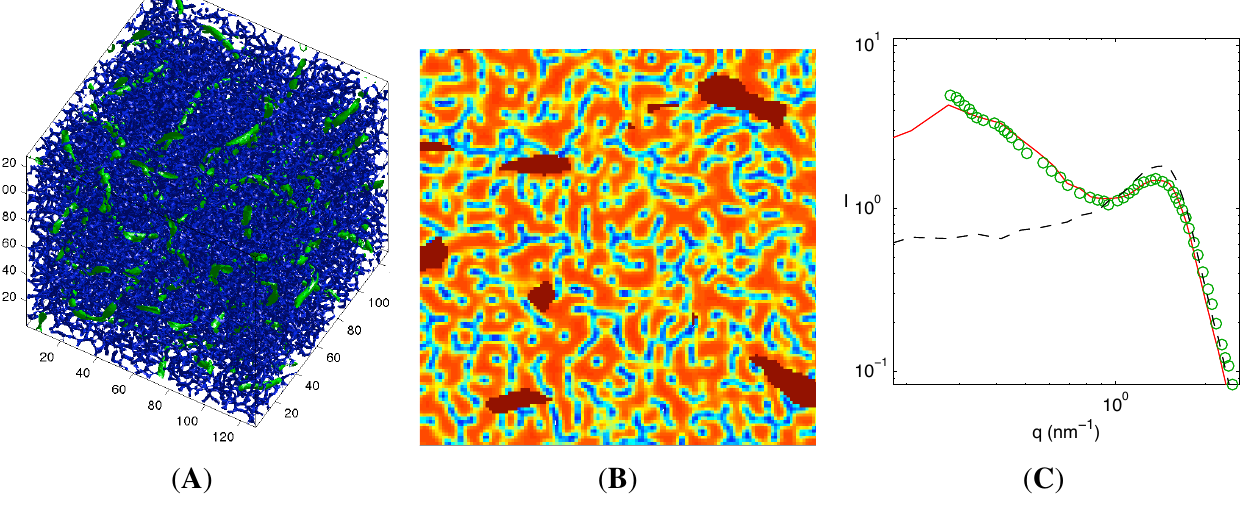
Figure 8. ( A ) Superposition of a 20% volume fraction solvent network (blue), calculated from the binary FCH energy with (cid:15) = η = 0 . 03 , η = 0 . 15 , and well tilt τ = 0 . 4 , with h m − 10% volume fraction crystalline network (green), calculated from the binary FCH energy with (cid:15) = η = 0 . 1 η = 0 . 2 and τ = 0 . 1 ; ( B ) Cross-section of solvent-crystalline h m − superposition, solvent (blue), polymer (orange), crystalline phase (red), enlarged with respect to ( A ) to show detail; ( C ) Small-angle X-ray (SAXS) scattering data: log of scattering intensity verses log of scattering parameter q , in units of (2 π nm) − 1 , (red circles) of Rubatat et al . [45] in a log( I ) versus log( q ) plot for Nafion at 20 vol% of H O, and simulated 2 SAXS curve from a water pore network produced by the FCH energy (black dotted line) and SAXS data from a superimposed water pore network and a crystalline network, both obtained separately from the binary FCH energy (solid red